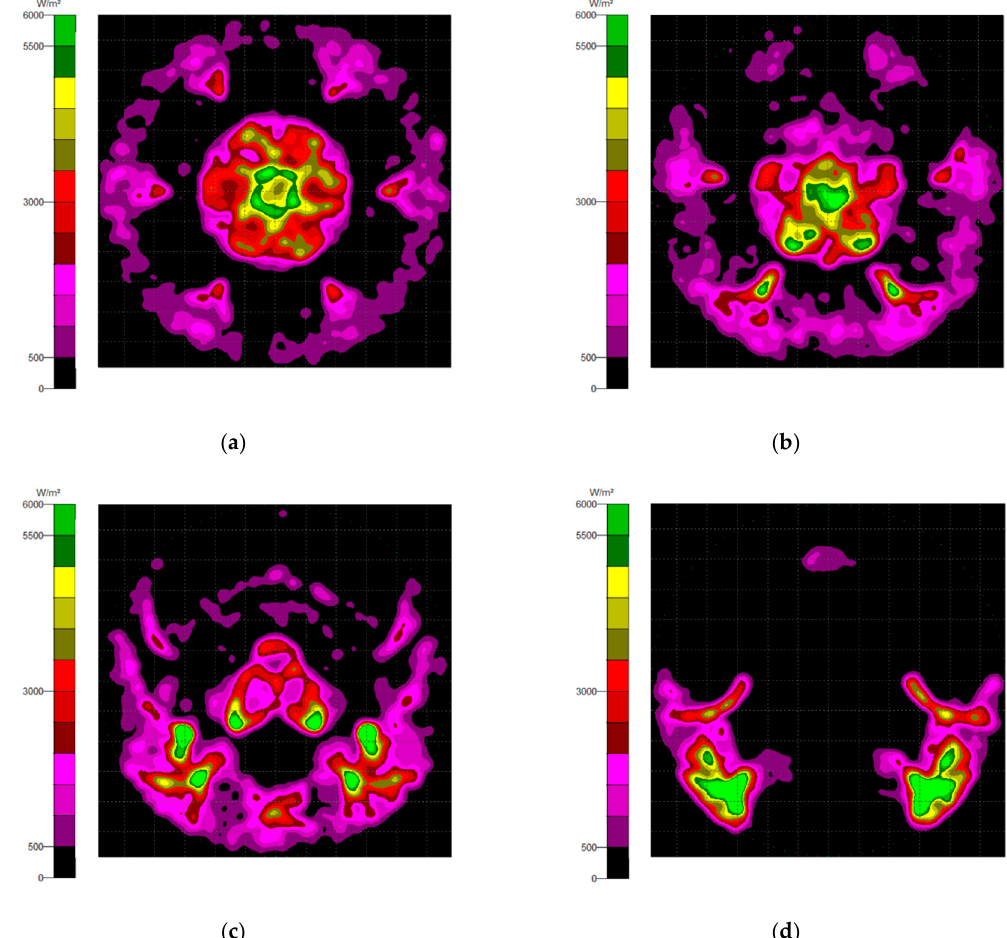
Figure 21. The irradiance distribution of the solid-NACPC and new TIR collimator with misalignment angles of ( a ) 0°, ( b ) 10°, ( c ) 20°, and ( d ) 30°.